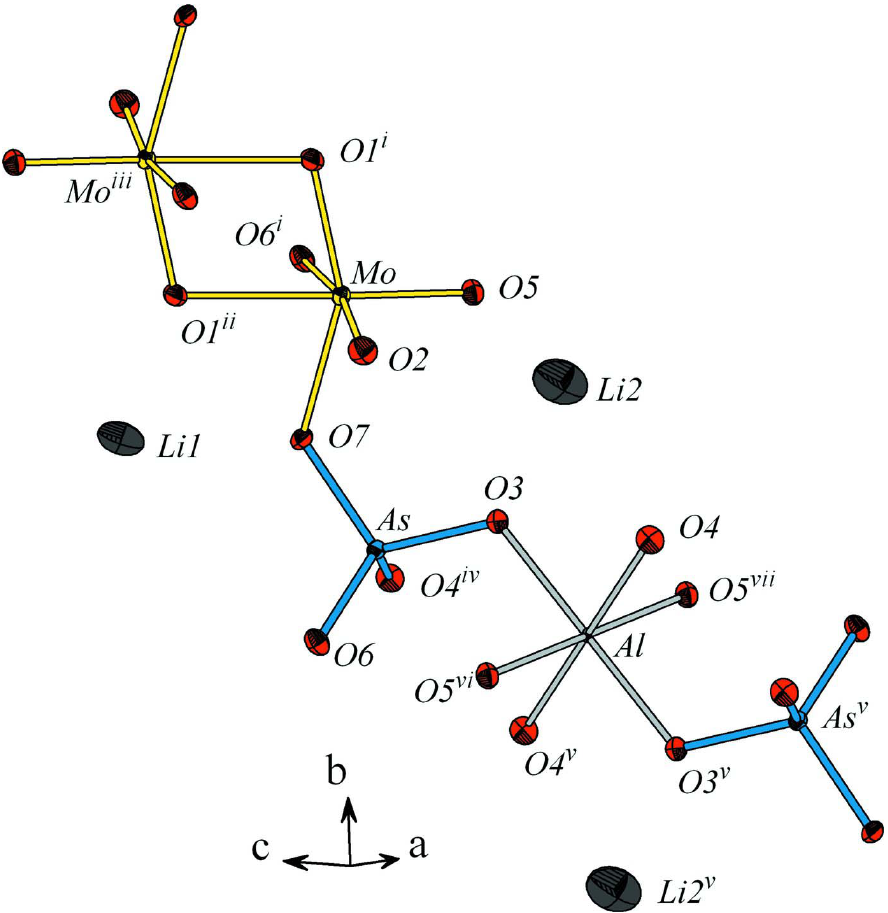
AlMo As O . Les ellipsoïdes d'agitation thermique ont 50% de probabilité. [Codes de symétrie: 3 2 2 14